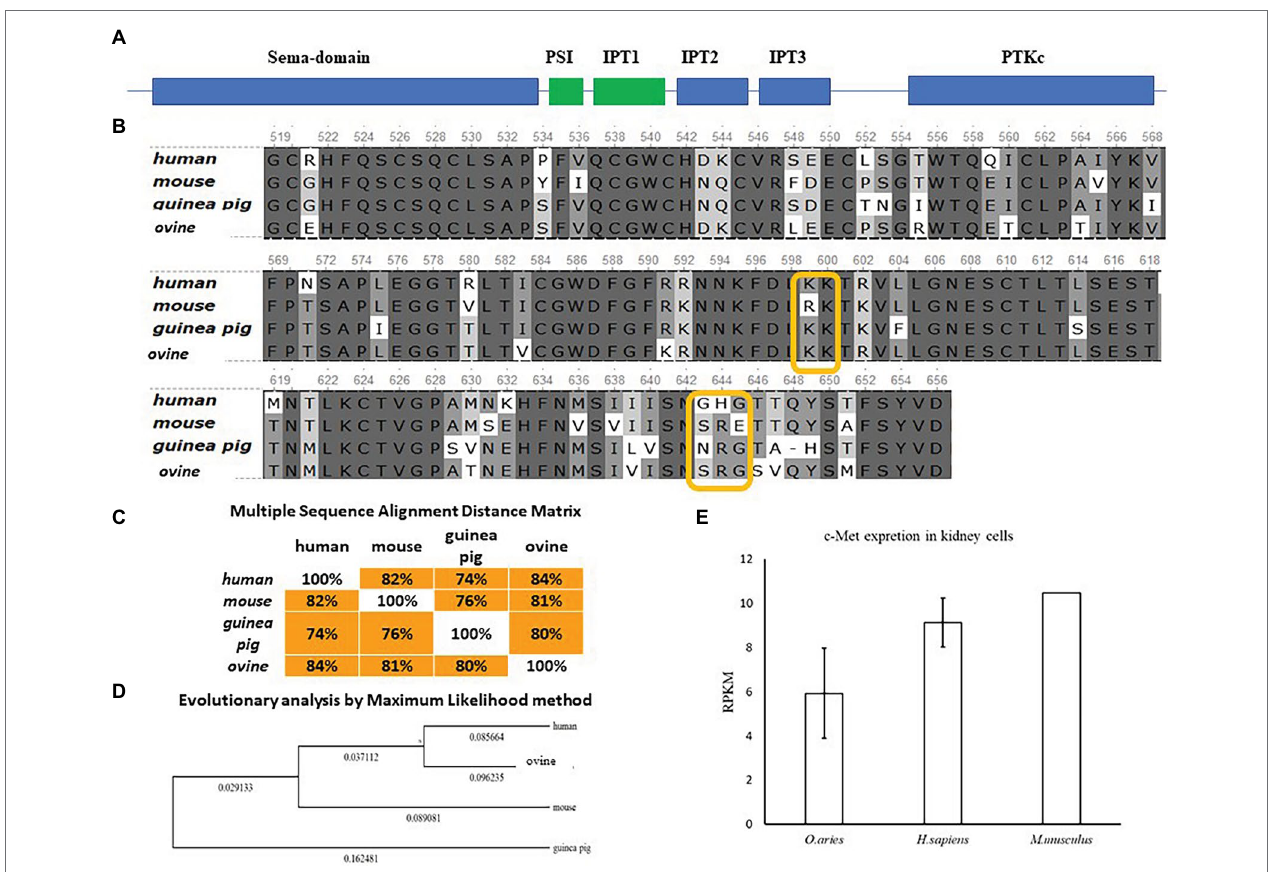
FIGURE 6 | Comparative analysis of c-Met in mammals of different orders. (A) Schematic representation of the c-Met structure. (B) Alignment of protein sequences from human, mouse, guinea pig, and ovine c-Met PSI-Ig1 domains (amino acids 519–659 of human c-Met) performed using the Clustal W program (Conway Institute UCD Dublin by Des Higgins, Dublin, Leinster, Ireland). The areas marked in orange are amino acids that are necessary for the interaction between c-Met and InlB. (C) To assess the matching of the distance between multiple sequence alignments, we utilized UniPro UGENE software. (D) The amino acid sequences were analyzed using the maximum likelihood method in MEGA 7.0 by using the Jones–Taylor–Thornton (JTT+G) model and with a bootstrapping of 500 replicates. The analysis involved five sequences of the c-Met PSI-Ig1 domains. The numbers at nodes represent bootstrap values. Branch lengths are scaled according to the numbers of amino acid substitutions per site. (E) Data on the presence of the c-MET receptor on Ovis aries (PRJEB6169), Homo sapiens (PRJEB4337), and Mus musculus (PRJNA215099) kidney epithelial cells were taken from the publicly available BioProject